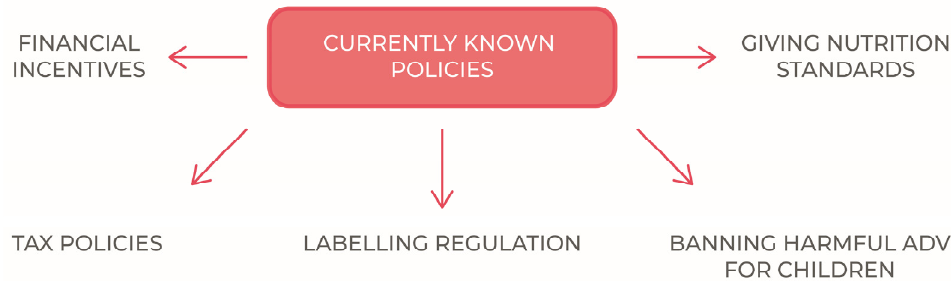
Figure 1. Currently known policies to tackle childhood